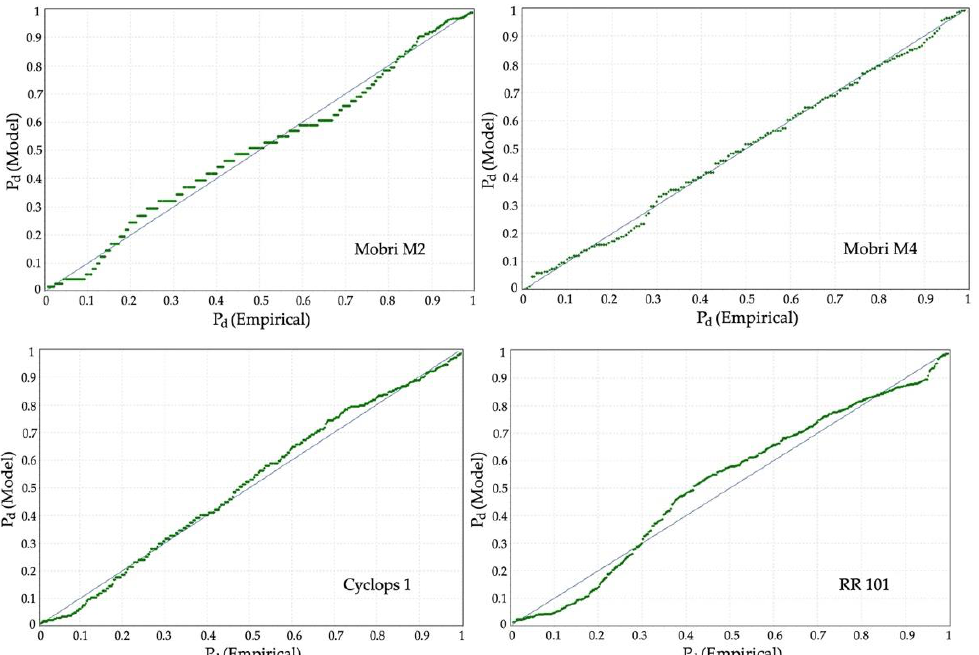
Figure 6. Plots of the small maritime target detection probability P d showing the conformity of the matching of the reflector’s parameters to the Weibull distribution for the Mobri M2, Mobri M4, Cyclops 1, and RR 101.